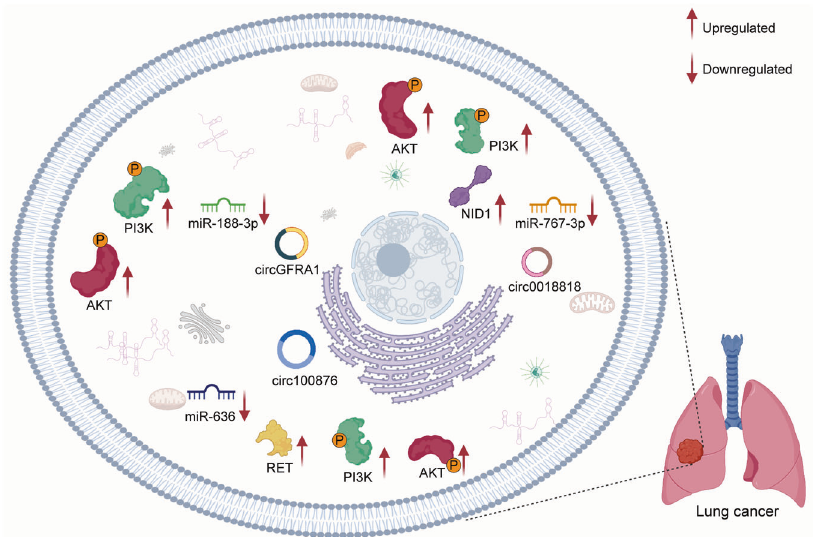
Fig. 5 The mechanism of circRNAs and PI3K/AKT pathway in lung cancer. CircGFRA1 activates the PI3K/AKT pathway by downregulating the expression of miR-188-3p in lung cancer. Circ100876 affects biological functions via PI3K/AKT signaling by regulating the miR-636/RET axis. The circ0018818/miR-767-3p/NID1/PI3K/AKT axis also plays a key role in the progression of lung cancer. Image created with BioRender (https://